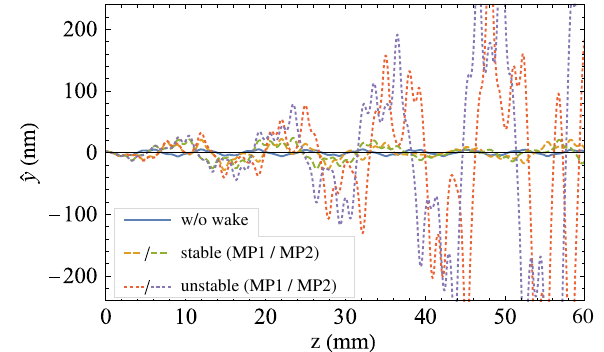
FIG. 9. Two-particle model using the APF transfer matrices with the wake of a dual pillar APF grating with 0 . 8 μ m period length. The y-offsets of both macroparticles (MP1 and MP2) are plotted respectively. The initial excitation without wake is shown for comparison (blue).